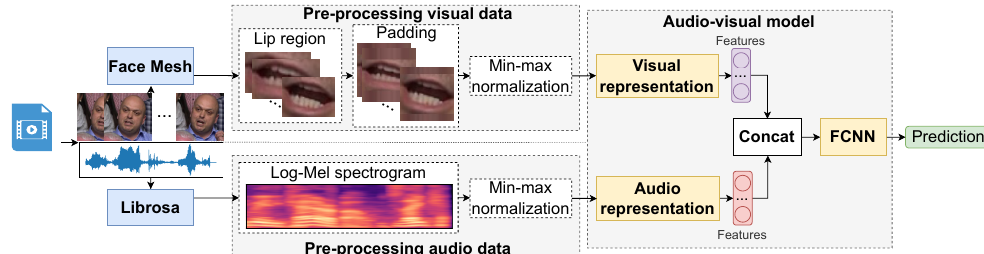
Figure 2. Proposed method for